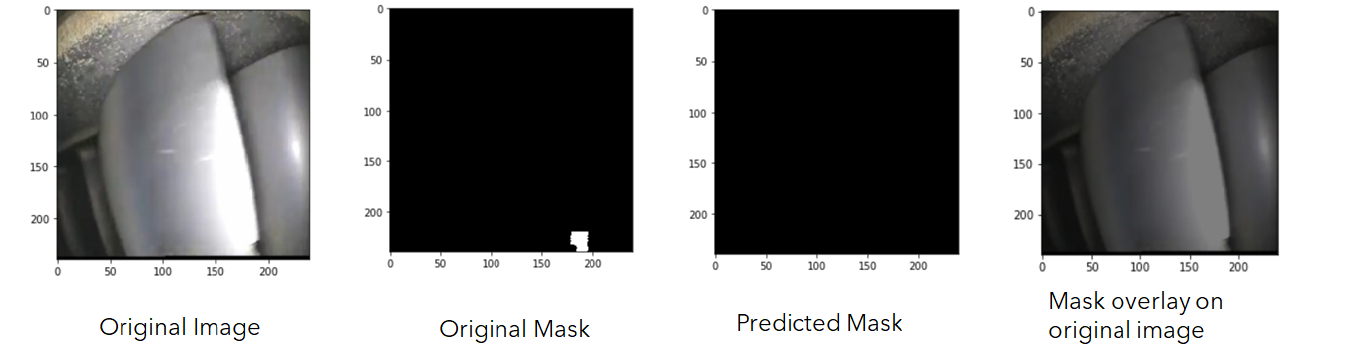
Figure 13. Image segmentation using blurred